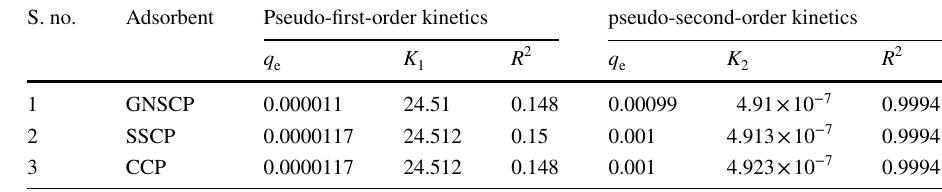
Table 3 Kinetic parameters for the adsorption of Cu(II) using the three